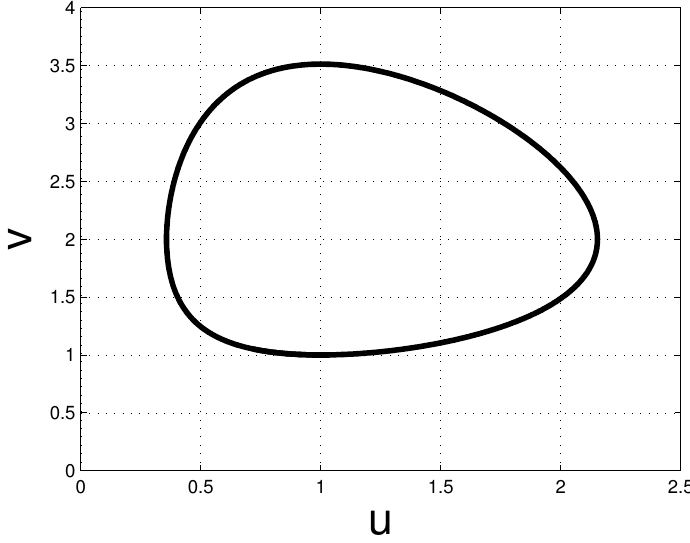
Figure 9. The reference solution for the Lotka–Volterra equations computed by integrating Equation (90) until the time T = 5 using Verner’s method with the time step h = 10 − 7 .